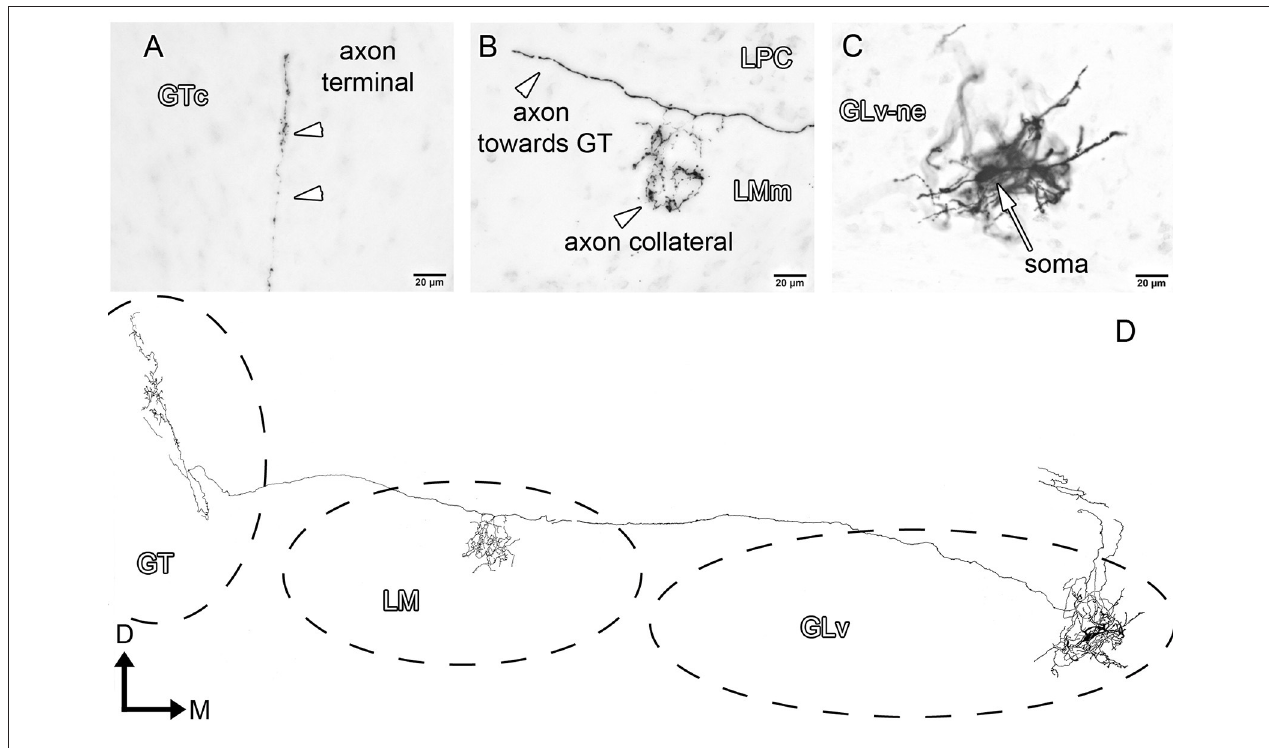
FIGURE 4 | Intracellular filling of a representative GLv-ne type II cell. (A–C) Photomicrographs showing axon collaterals in LM/GT, and the location of the soma. White arrowheads indicate the different neuronal processes in LMm and GTc. (D) Reconstruction of the biocytin-filled neuron. D, dorsal; M, medial. Orientation in (D) applies to (A–C)